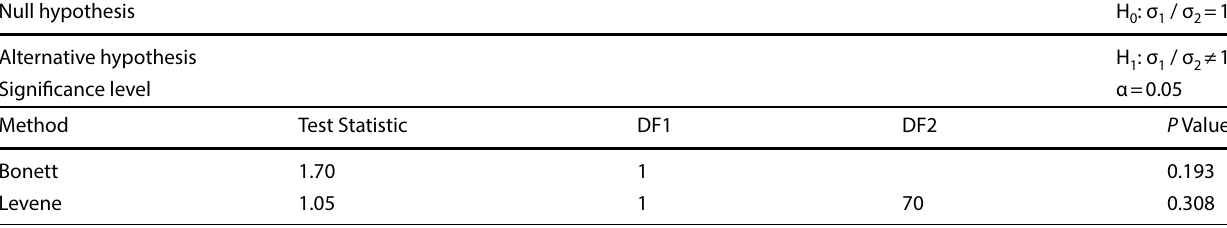
Table 21 Equality of variance test